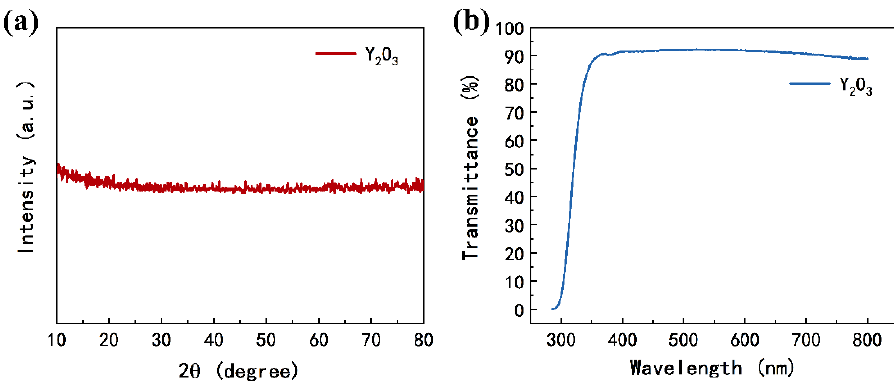
Figure 2. ( a ) XRD pattern of Y 2 O 3 film. ( b ) Transmission rate of Y 2 O 3 film.